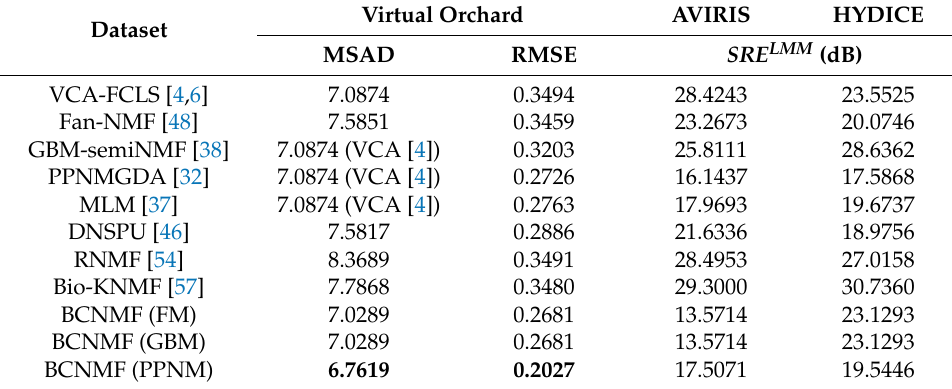
Table 12. Comparison of the algorithms for the virtual orchard and real hyperspectral